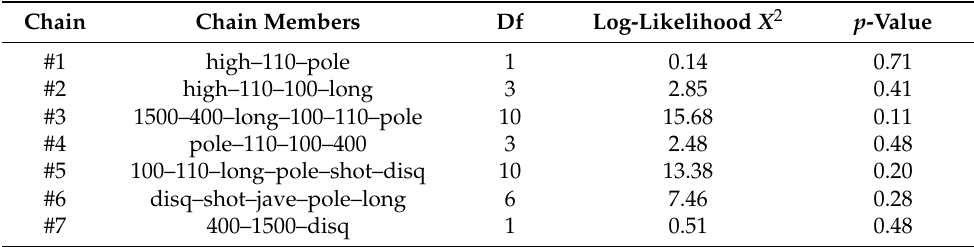
Table 2. The seven association chains detected in the performance results of 33 Olympic decathletes (sample 1). p -values were calculated as the right tail probability of the X 2